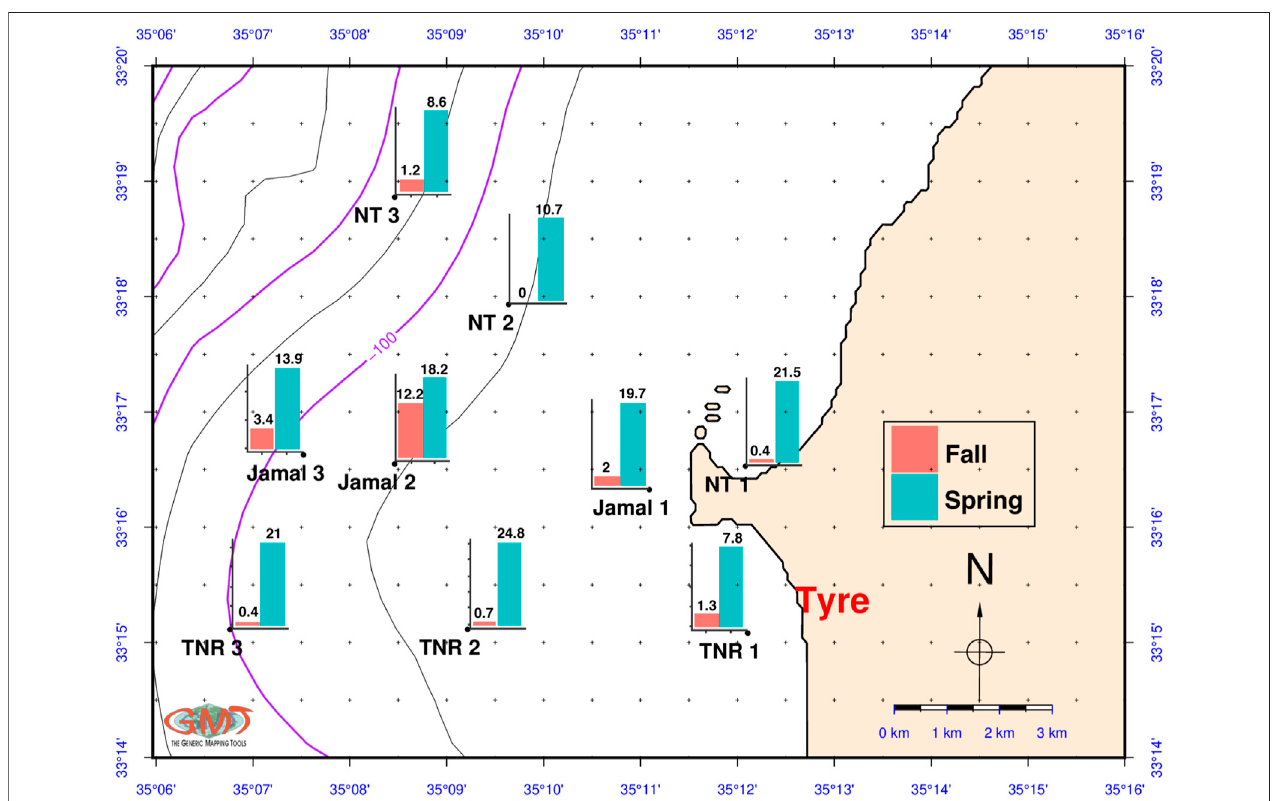
FIGURE 5 | The distribution and concentration (items/m 3 ) of total microplastics during the spring and fall seasons in Tyre marine area.